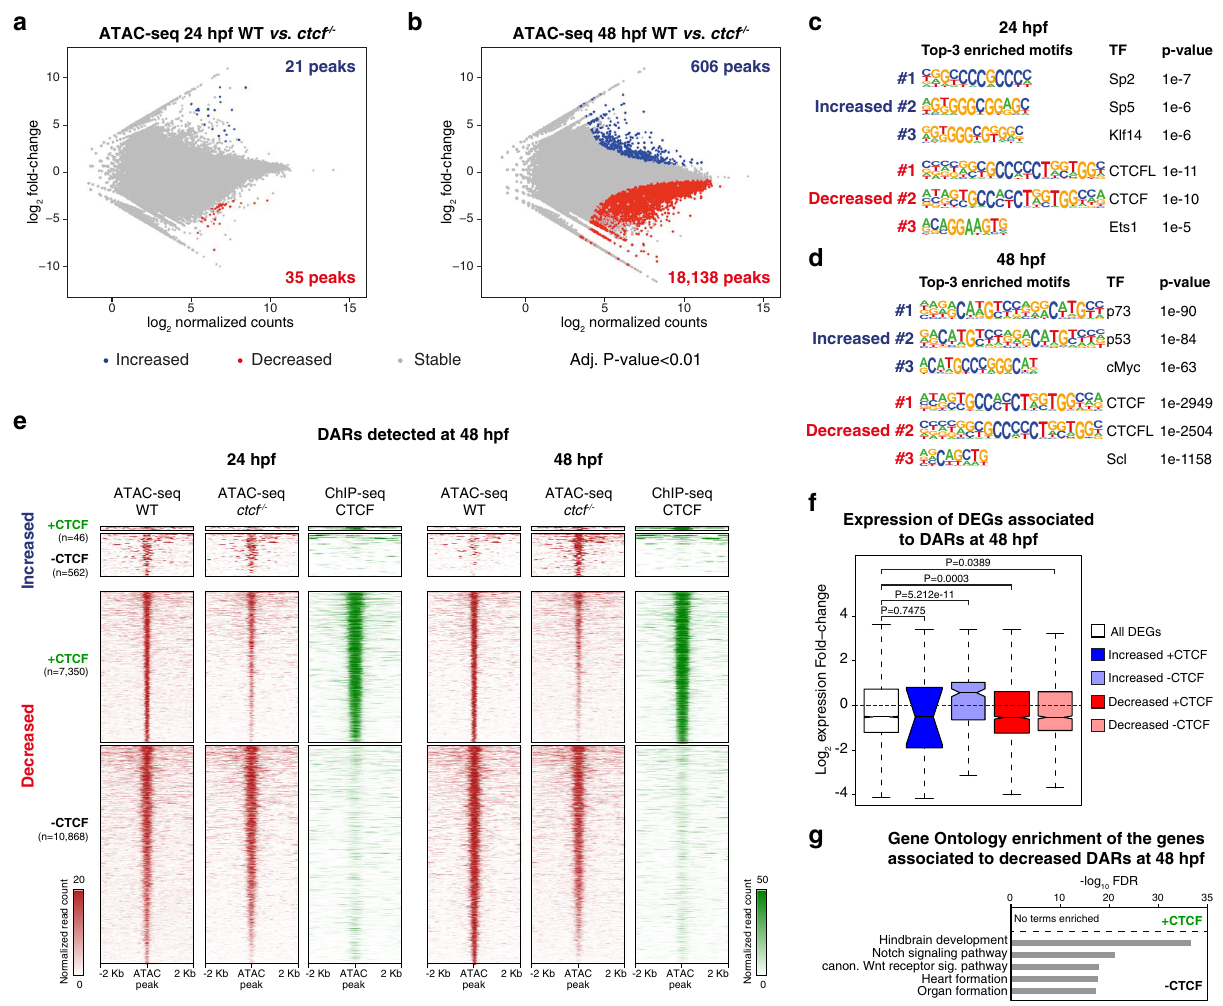
Fig. 4 CTCF promotes chromatin accessibility at developmental cis -regulatory elements. a , b Differential analyses of chromatin accessibility between WT and ctcf − / − embryos at 24 ( a ) and 48 hpf ( b ) from ATAC-seq data ( n = 2 biological replicates per condition). The log 2 normalized read counts of WT ATAC peaks versus the log 2 fold-change of accessibility are plotted. Regions showing statistically signi fi cant differential accessibility (adjusted P - value < 0.01) are highlighted in blue (increased) or red (decreased). The total number of differential peaks is shown inside the boxes. c , d Motif enrichment analyses for the increased and decreased ATAC peaks in ctcf − / − embryos at 24 ( c ) and 48 hpf ( d ). The three motifs with the lowest p-values are shown for each case. e Heatmaps plotting normalized ATAC-seq signal in WT and ctcf − / − embryos (red), as well as CTCF ChIP-seq signal (green) at 48 hpf, for the differentially accessible regions (DARs) from ( b ) overlapping or not with CTCF sites. f Box plots showing the expression fold-change in ctcf − / − embryos at 48 hpf of all DEGs or only those associated with increased or decreased DARs, overlapping or not with CTCF sites. Boxplots represent the centerline, median; box limits, upper and lower quartiles; whiskers, 1.5× interquartile range; notches, 95% con fi dence interval of the median. Statistical signi fi cance was assessed using a two-sided Wilcoxon ’ s rank-sum test. g GO enrichment analyses of biological processes for the genes associated with decreased DARs in ctcf − / − embryos at 48 hpf, overlapping or not with CTCF sites. GO terms showing an FDR < 0.05 are considered